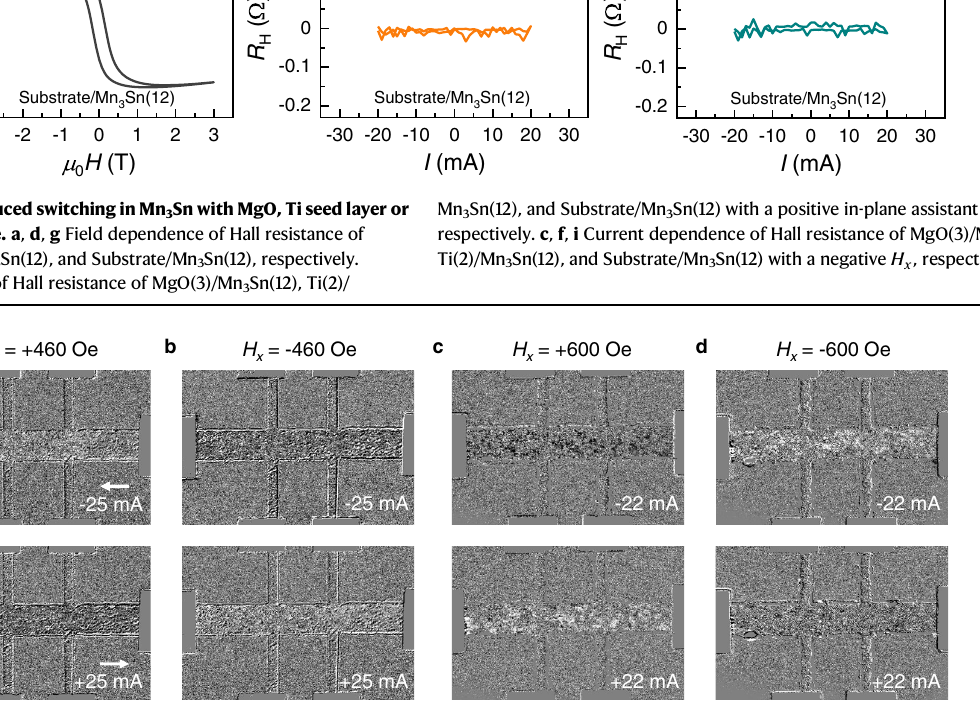
Ta(2)/MgO(4)/Mn 3 Sn(12) after application of a longitudinal current with an ampli- tude of − 22 mA (upper panel) and 22mA (lower panel) in a longitudinal fi eld H x of +600Oe and − 600Oe, respectively.